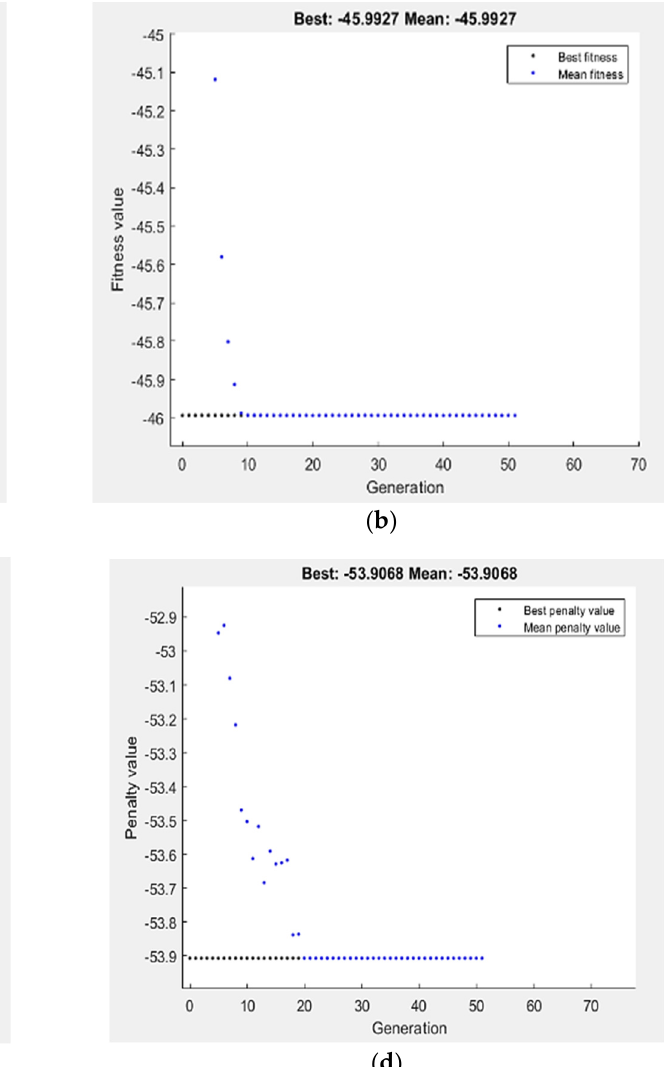
( b ) Figure 16. Optimum G R by GA ( a ), and hybrid RSM-GA ( b ). The optimization of hardness response by GA is presented in Figure 17. The maximi-